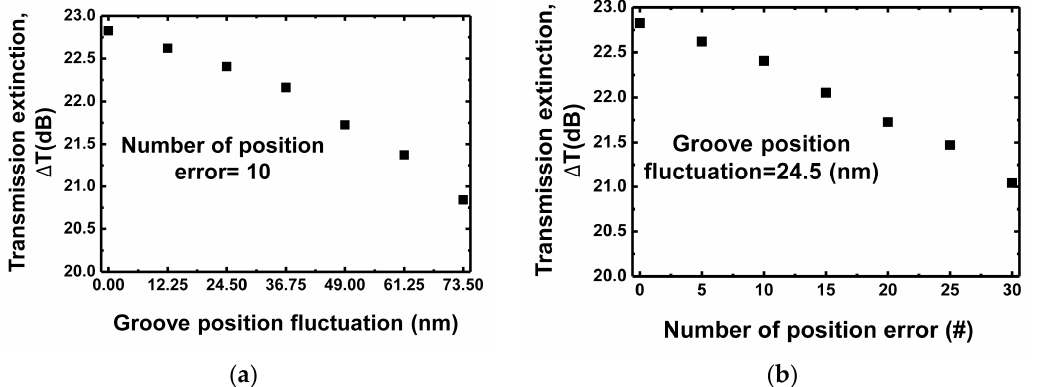
Figure 7. ( a ) Effect of groove position fluctuation on transmission extinction ∆ T; ( b ) Effect of the number of error positions on ∆ T. The grating period is 490 nm, the etching depth is 75 nm, and the duty ratio is 0.5.